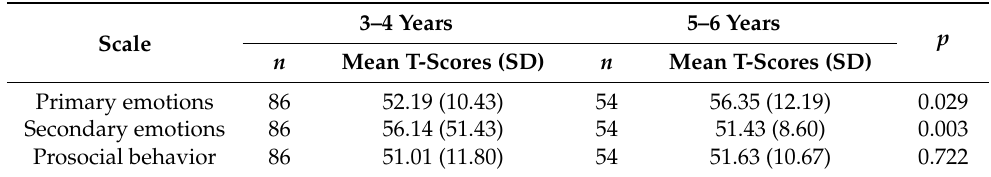
Table 3. Results of the distribution of the scores of the EMK 3–6 scales (emotional and social competences) in the age groups.